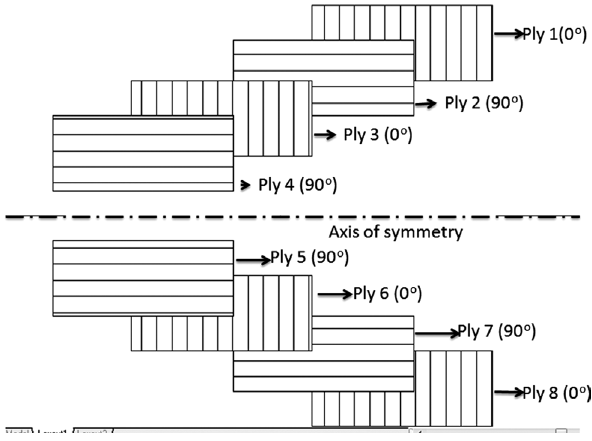
Figure 1 Diagrammatic sketch for different plies used in manufac- turing [0/90] . 2s